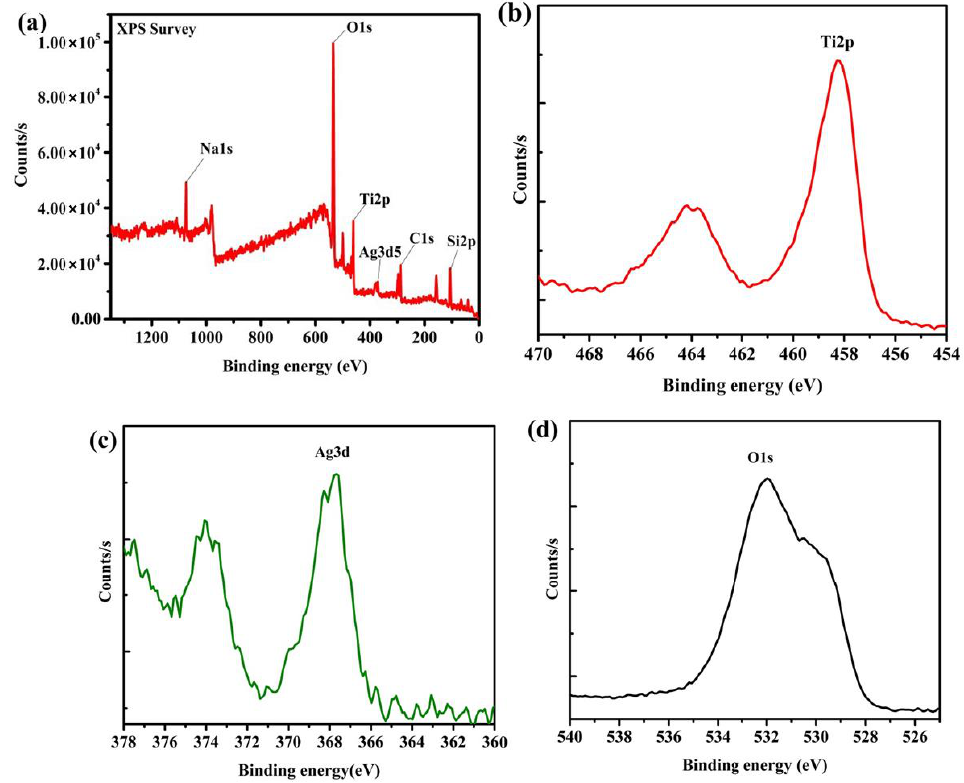
Figure 4. XPS spectra on the surface of Ag-TiO 2 /Sr 4 Al 14 O 25 :Eu 2+ ,Dy 3+ beads ( a ) survey, ( b ) Ti 2p, ( c ) Ag 3d, and ( d ) O 1s.